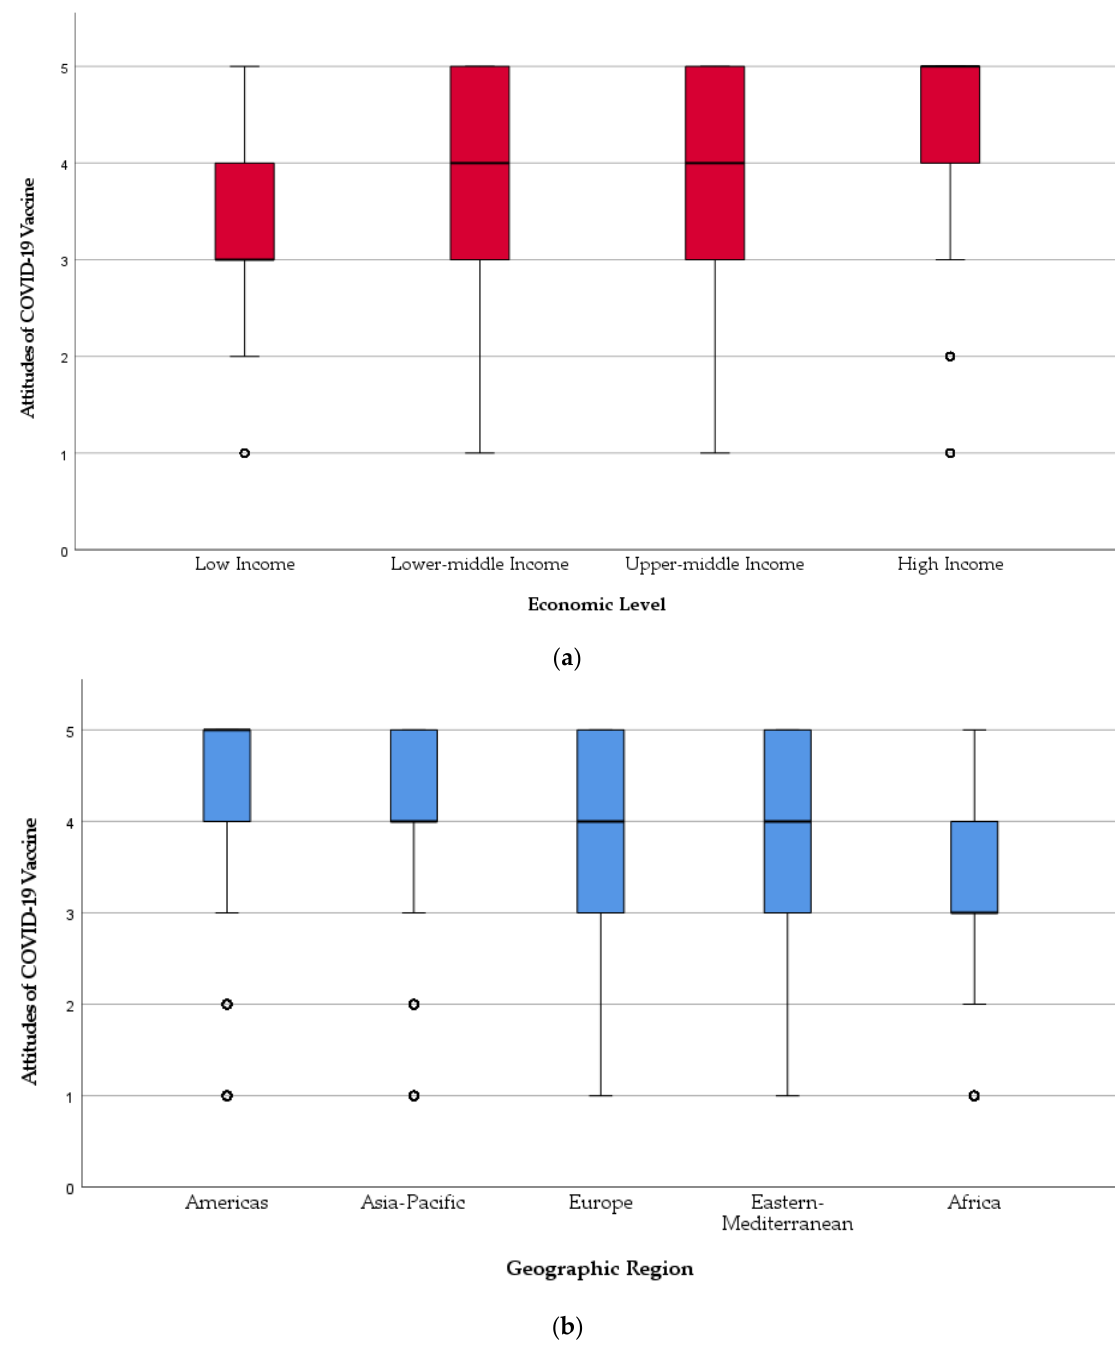
Figure 1. Dental students’ COVID-19 vaccine acceptance level by state, February 2021.